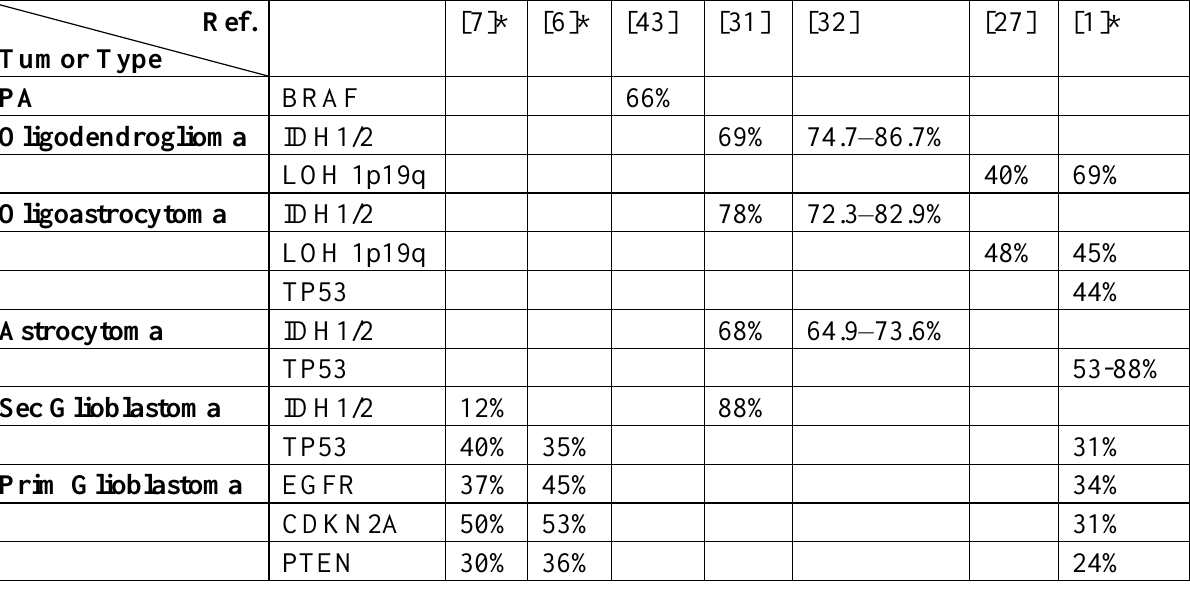
Table 1. Genes or regions with the most characteristic genetic alterations in glioma subtypes. * % are calculated on a mixture of primary and secondary glioblastoma. LOH: loss of heterozygosity; PA: Pilocytic Astrocytoma.